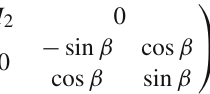
Figure6showsthedependenceon ϕ M